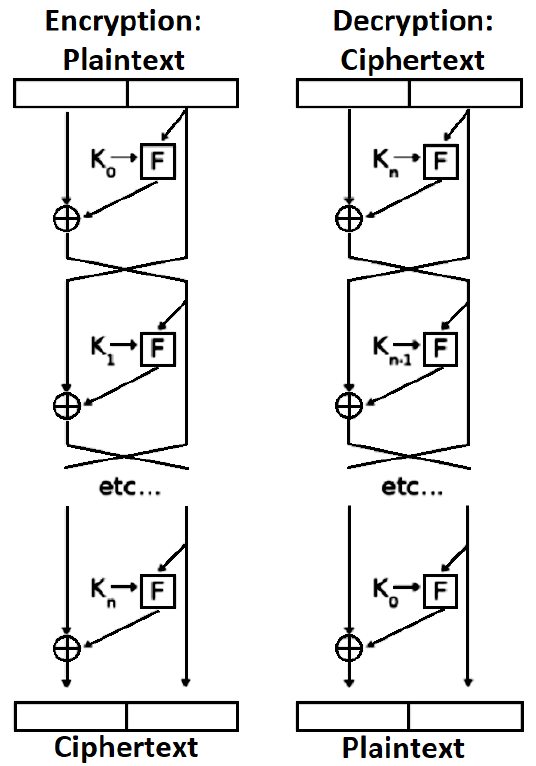
Figure 1. CAST-128 encryption and